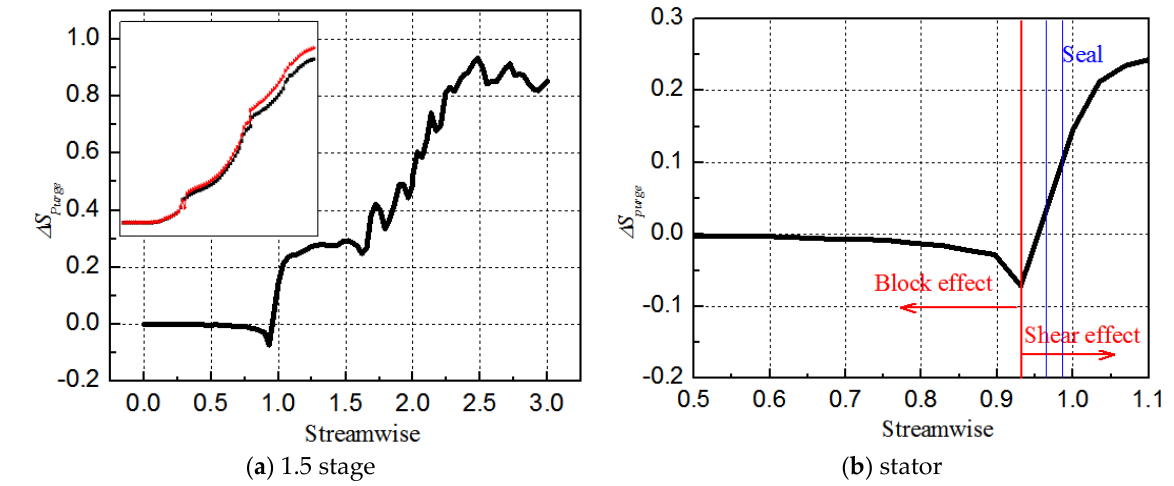
s  ) along the flow direction( IR=1.5% ). Figure 6. Distribution of entropy increase ( ∆ s Purge ) along the flow direction ( IR = 1.5% ).